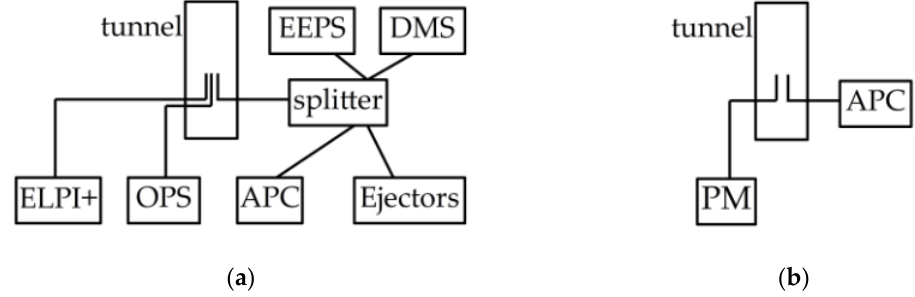
Figure 2. Experimental setup employed in the ( a ) first and ( b ) the second phase of the measurement campaign.